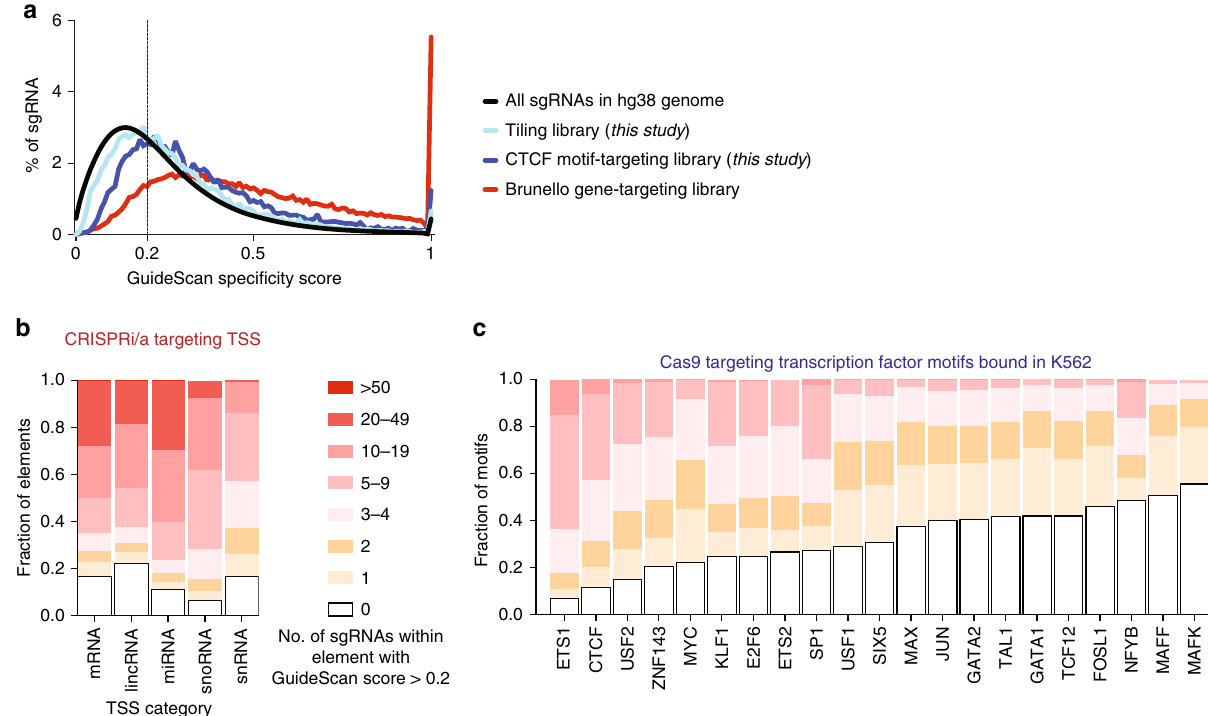
Fig. 4 High-speci fi city CRISPR-Cas9 screen designs for non-coding elements. a Distribution of GuideScan speci fi city scores for two non-coding libraries from this study and a gene-targeting library, in comparison to all possible sgRNA. b Most TSSs can be targeted with multiple high-speci fi city sgRNA. Fraction of TSS in the ENCODE SCREEN database of ccREs that can be targeted with dCas9-based epigenome editors within a window of + / − 100 bp, after fi ltering for GuideScan scores >0.2. c Fraction of motifs in TFBS motifs that can be targeted with sgRNAs with a cut site in the motif, after fi ltering out